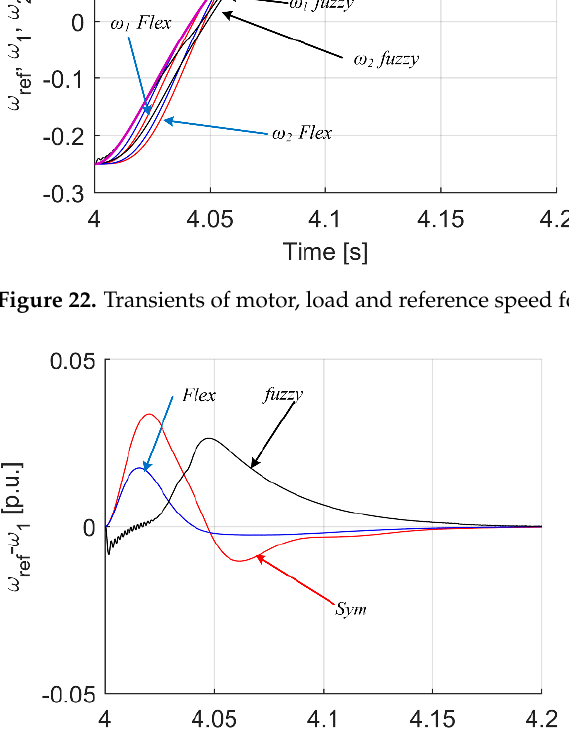
Figure 23. Transients of difference between motor and load speed for case of reference speed change.